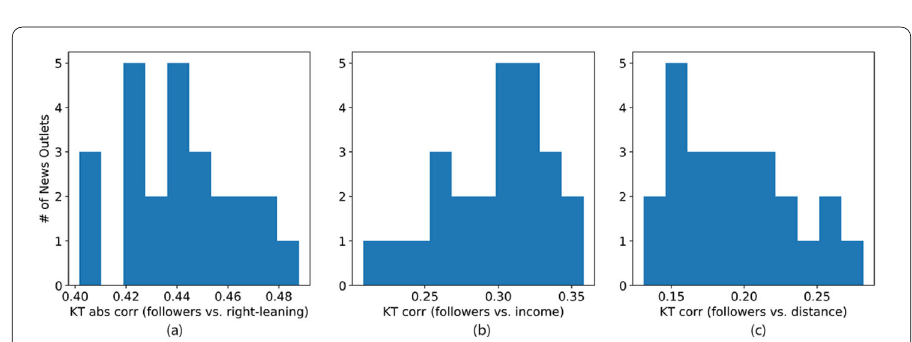
Figure 5 Distribution of the KT correlation for communes in the Metropolitan Region for the top 25 news outlets